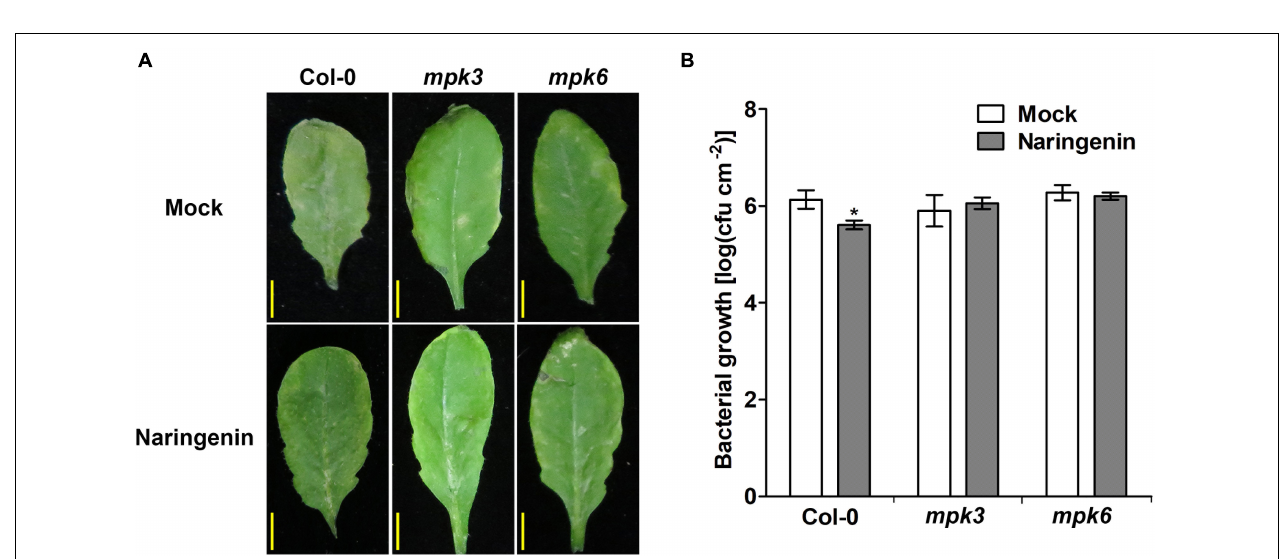
FIGURE 7 | Pathogen resistance by naringenin is compromised in mpk3 and mpk6 mutants. (A) Disease symptoms of Pst DC3000-treated Col-0, mpk3 and mpk6 mutant in the absence and presence of naringenin. (B) The growth of Pst DC3000 in control or in naringenin-pretreated Col-0, mpk3 and mpk6 mutant plants. Details as described in Figure 1 . Scale bar represents 0.5